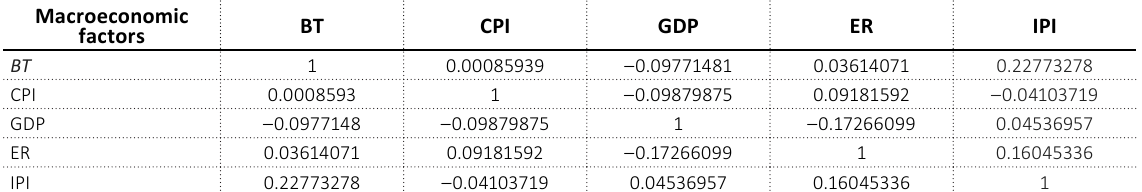
Table 7. Results of macroeconomic factors impact on Amman market index returns